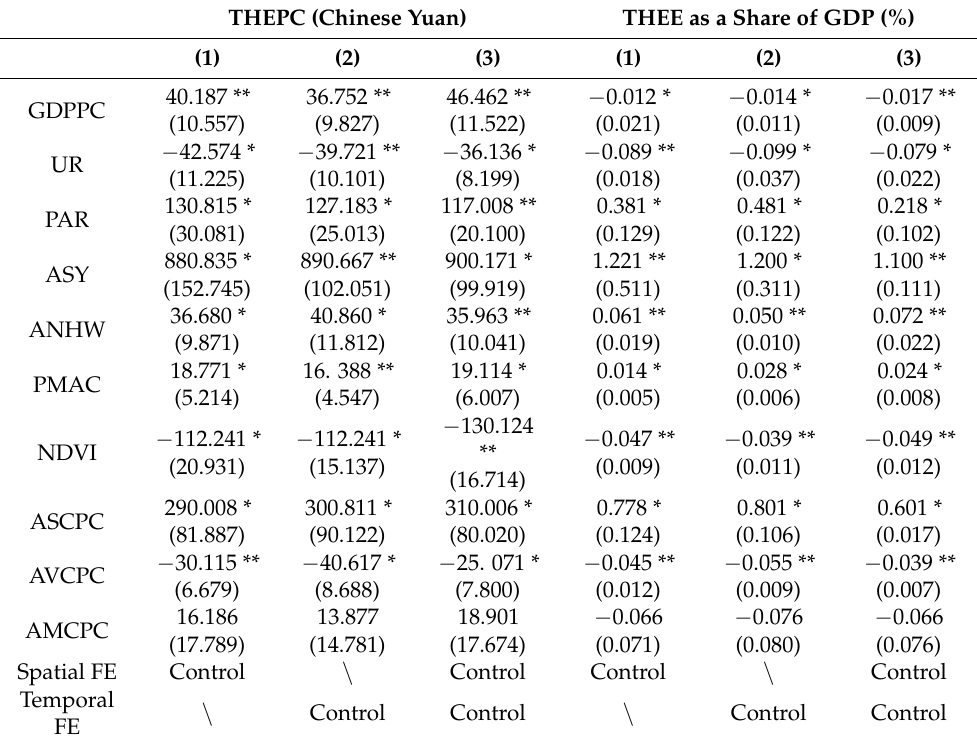
Table 3. The estimated coefficients of the selected 10 variables on the THEPC and the THEE’s GDP share by the ordinary least squares regression